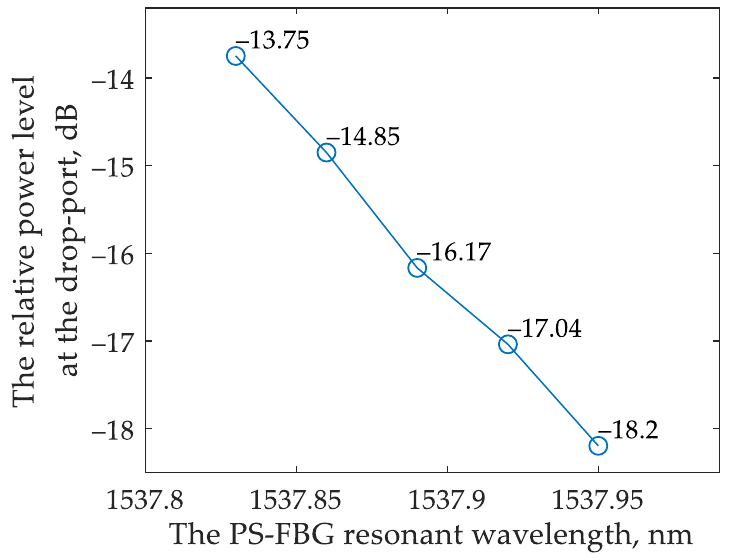
Figure 18. Relative power at the interrogator drop port versus the resonant wavelength of the PS-FBG in the scheme with OEO.